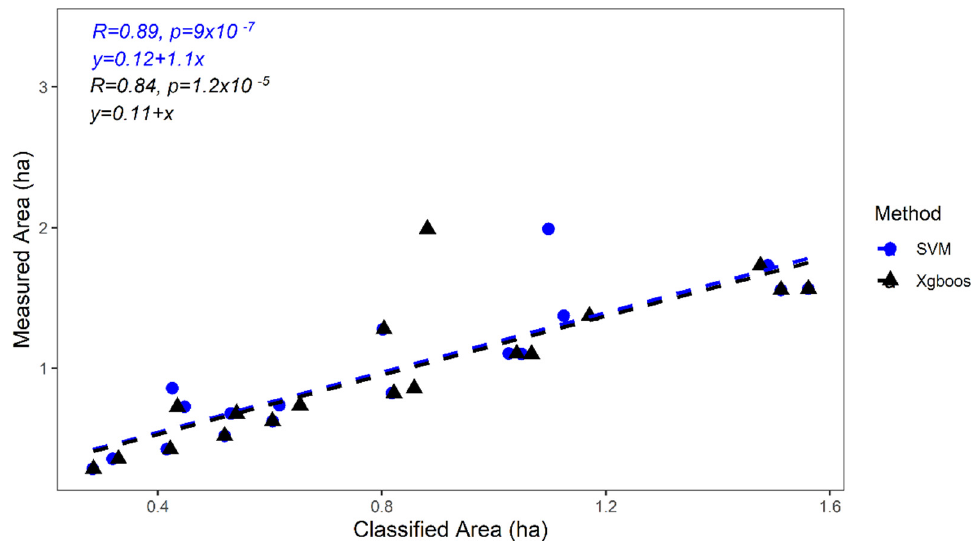
Figure 8. Comparison of the field measured areas (y) to those generated by the classification models (x) applying the SVM and Xgboost algorithms.